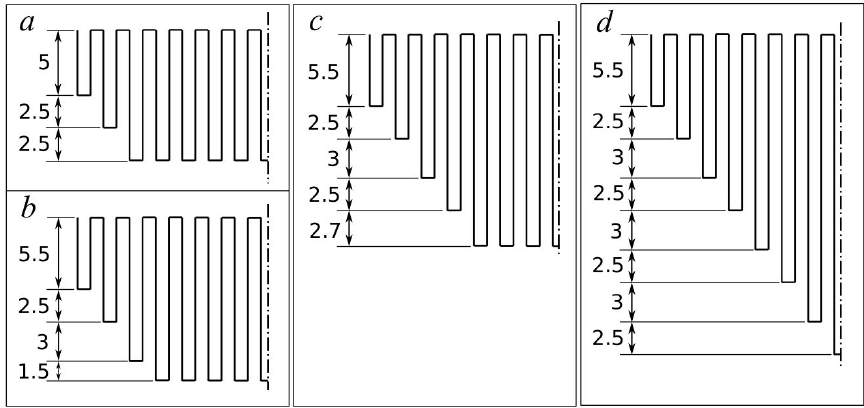
Figure 8 . Fin geometries of heat absorbers simulated. ( a ) Dimensions of the original case tested and validated in Section 3 (ATEG total heat exchanger surface area A t = A t,o = 418 cm 2 ); ( b ) A t = 1.2 A t,o ; ( c ) A t = 1.4 A t,o ; ( d ) A t = 1.6 A t,o . Fin thickness: 1 mm. Fin-to-fin distance: 1 mm. Fin length = 30 mm.